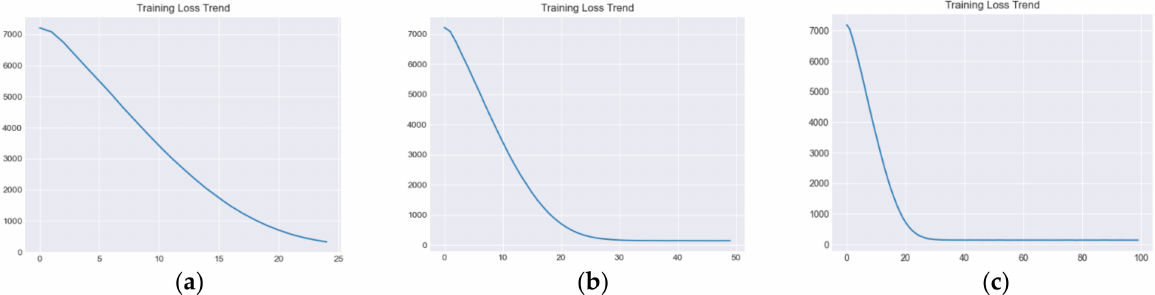
Figure 5. Losses of the C-LSTM model with selected cross-entropy loss functions and Adam optimizer for a different number of iterations. ( a ) The loss when the number of iterations is 25, ( b ) the loss when the number of iterations is 50, ( c ) the loss when the number of iterations is